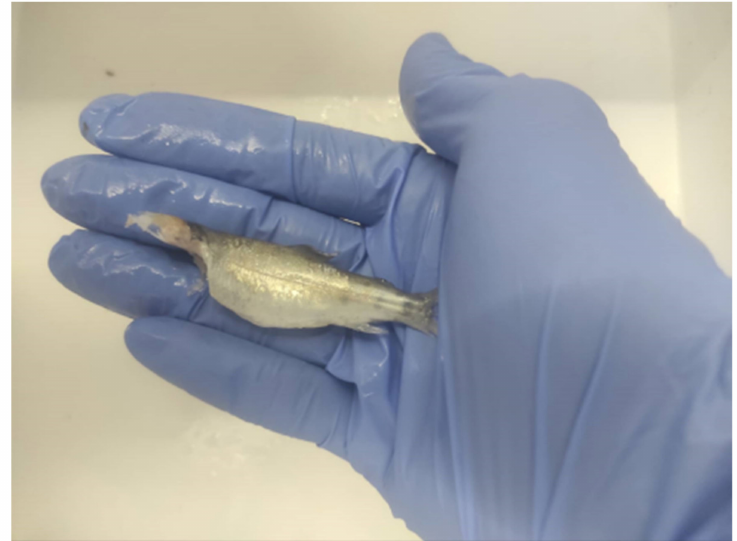
Figure 4. Rainbow trout juvenile after cannibalism observed in an experimental